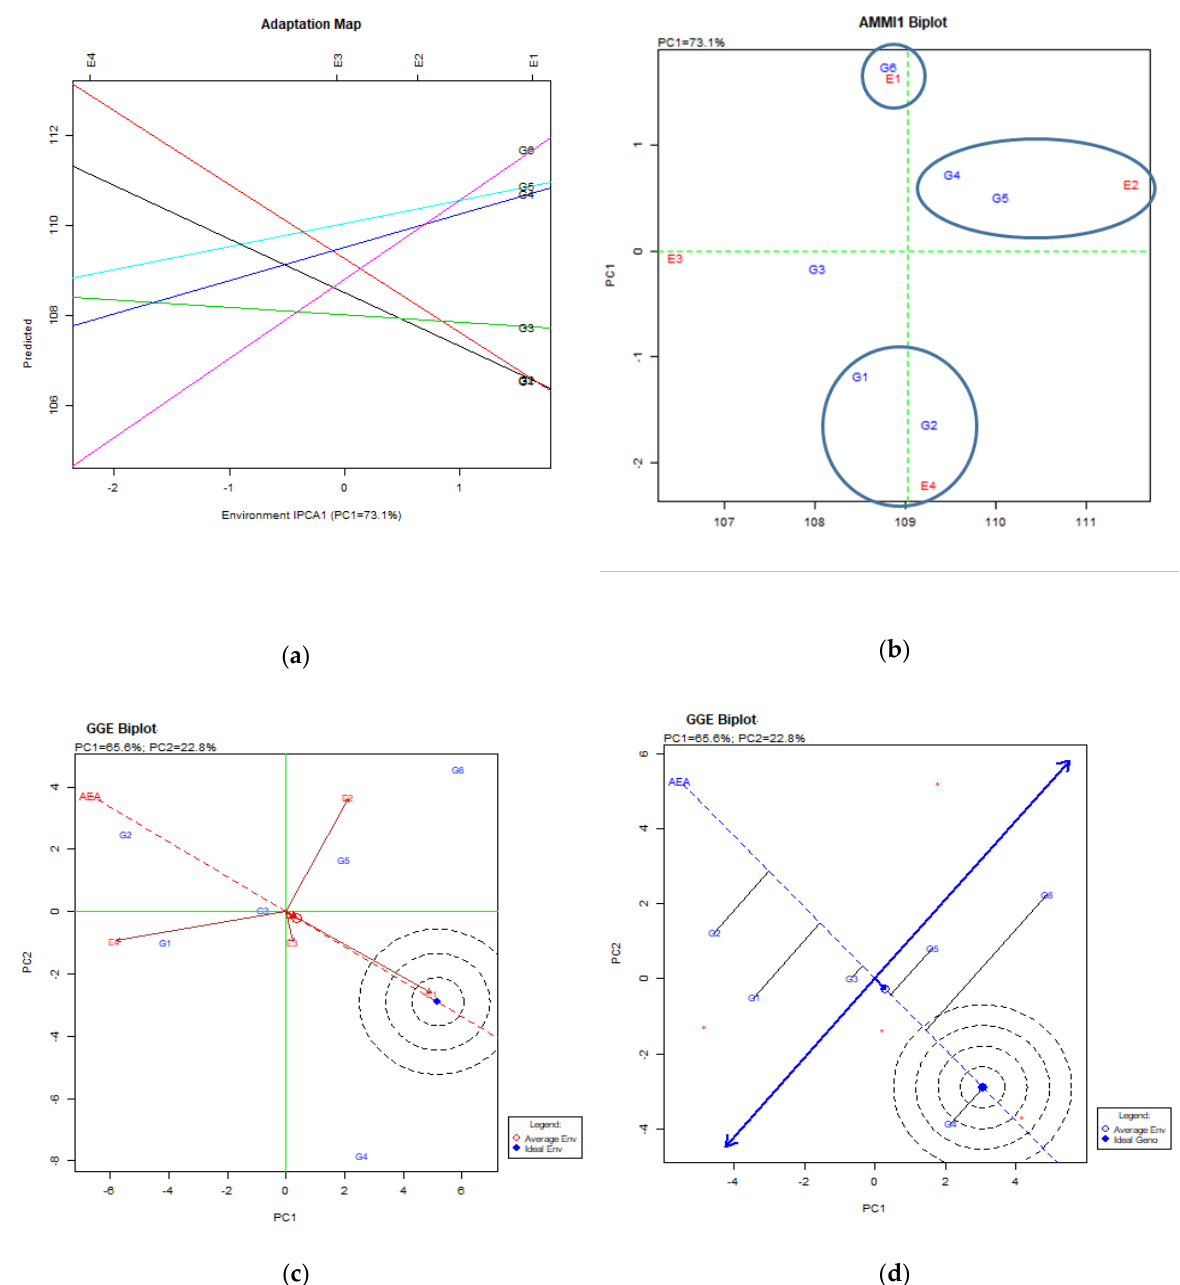
Figure 4. Stability analysis for the number of seeds per plant based on ( a ) the adaptation map where the X-axis (PC1) visualizes the stability of varieties over environments and the Y-axis — the performance of varieties for the trait; ( b ) the AMMI1 biplot where the Y-axis is the one visualizing the trait performance and the X-axis (PC1) visualizes the stability of varieties over environments; ( c ) the GGE biplot for environments depicting the stability of the environments over years via the placement as near as possible to the ideal and average environment; ( d ) the GGE biplot for varieties depicting the stability of the varieties over environments where the productive varieties are those to the right on the AEA vector and the stable ones are those which are as close to the AEA axis as possible.